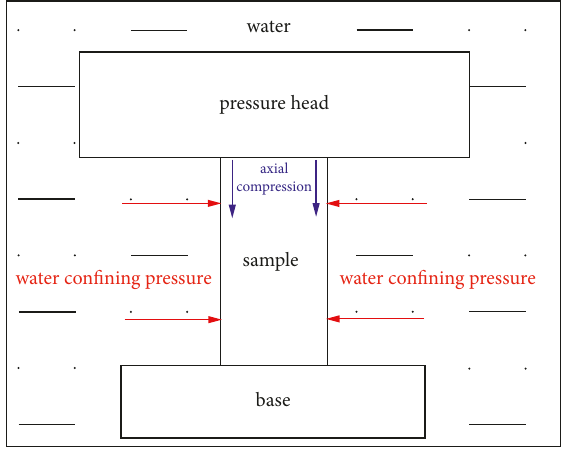
Figure 9: Stress diagram of rock